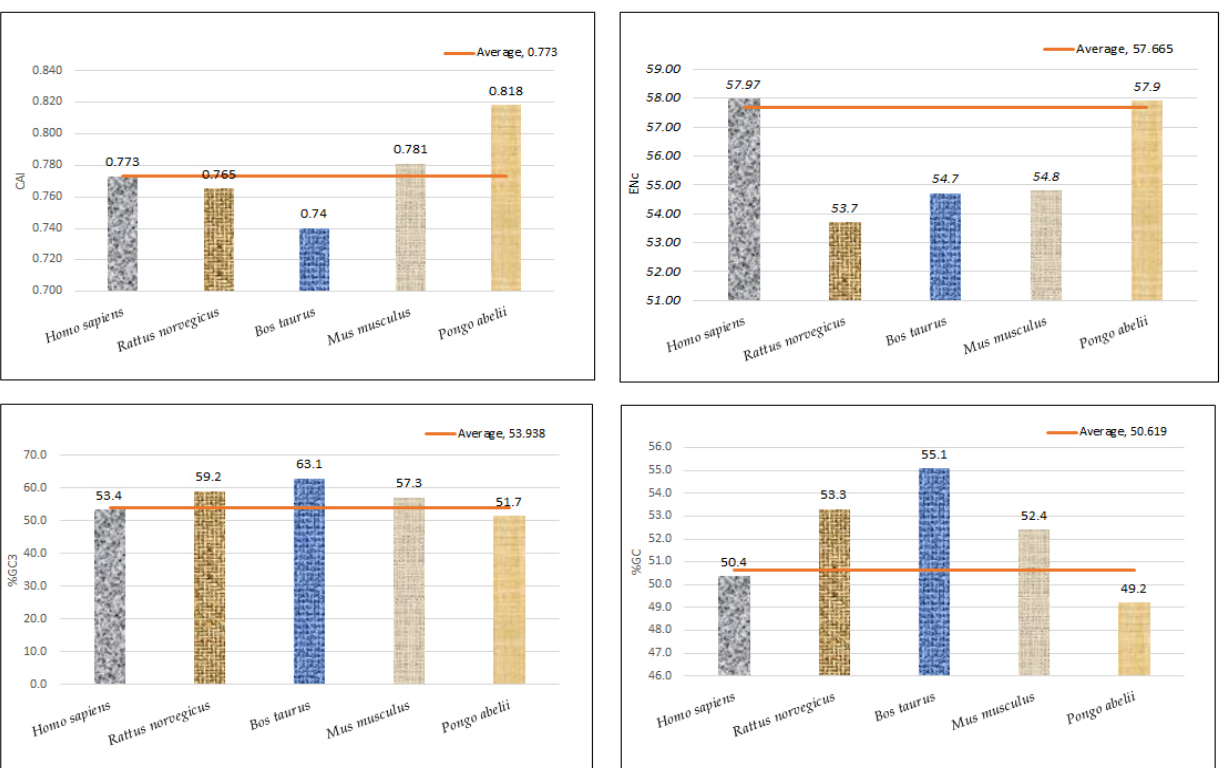
Figure 7. Graphical representation of CAI, ENc, GC3%, and GC% with their mean values.